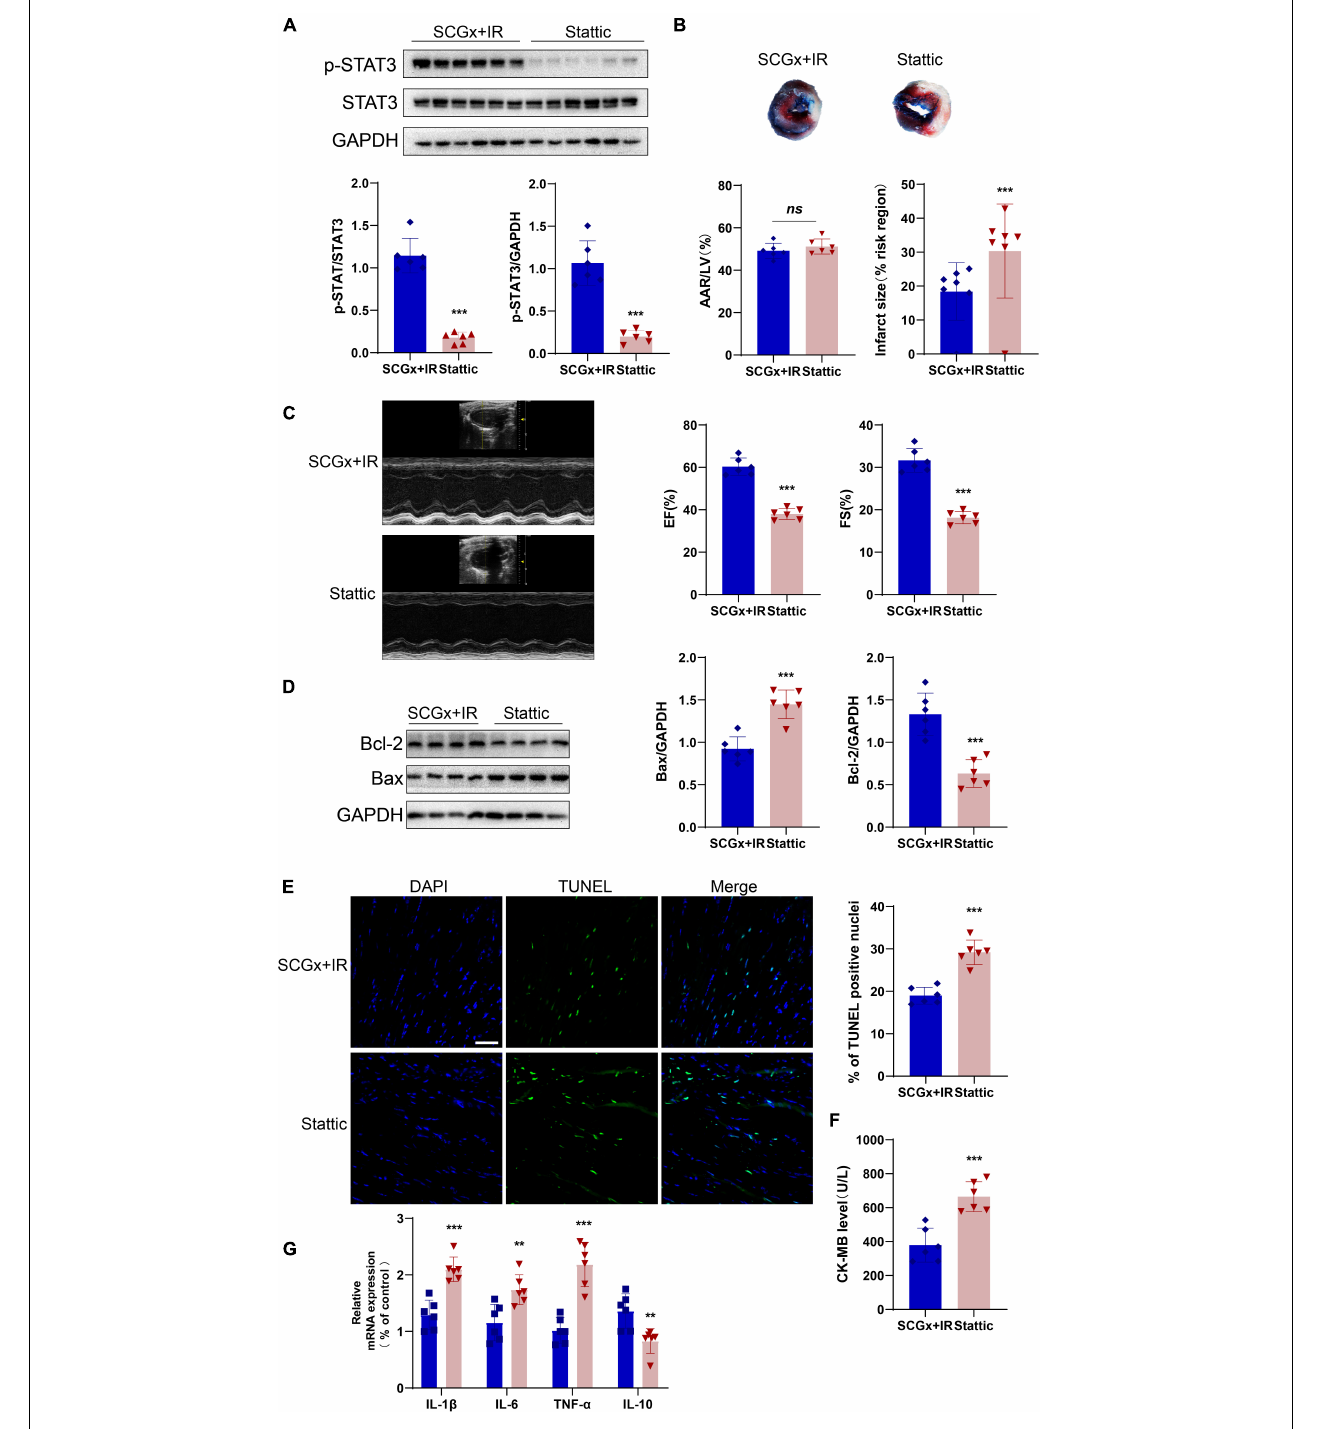
FIGURE 6 | Stattic partially attenuated the protective effect of sympathetic denervation on the myocardial ischemia-reperfusion injury. (A) The expression of p -STAT3 protein was significantly inhibited by stattic (20mg/kg, ip ). (B) Representative photographs of Evans blue and 2,3,5-triphenyltetrazolium chloride double-stained heart sections. (C) Representative M-mode echocardiography images. left ventricular ejection fraction (LVEF), left ventricular fractional shortening (LVFS). (D) The expression of Bcl-2 protein was decreased after p -STAT3 protein was inhibited, and Bax protein was increased. (E) Representative fluorescent images and percentage of TUNEL positive nuclei in each group. (F) Quantitative analysis of the proportion of myocardial infarction area. Detection of creatine kinase-MB (CK-MB) in mice serum. (G) Determination of inflammation-related mRNAs by PCR in total RNA prepared from the myocardium. interleukin-10 (IL-10) and interleukin-6 (IL-6), Interleukin-1 β (IL-1 β ), tumor necrosis factor alpha (TNF- α ). n = 6, 0.001 < ** P < 0.01 and *** P < 0.001 compared with the SCGx + IR group.